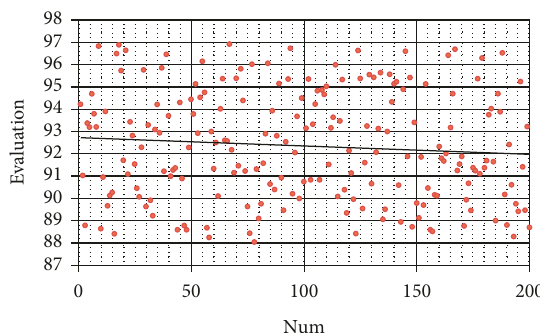
Figure 10: Evaluation of the intelligent effect of intelligent vector control algorithm.